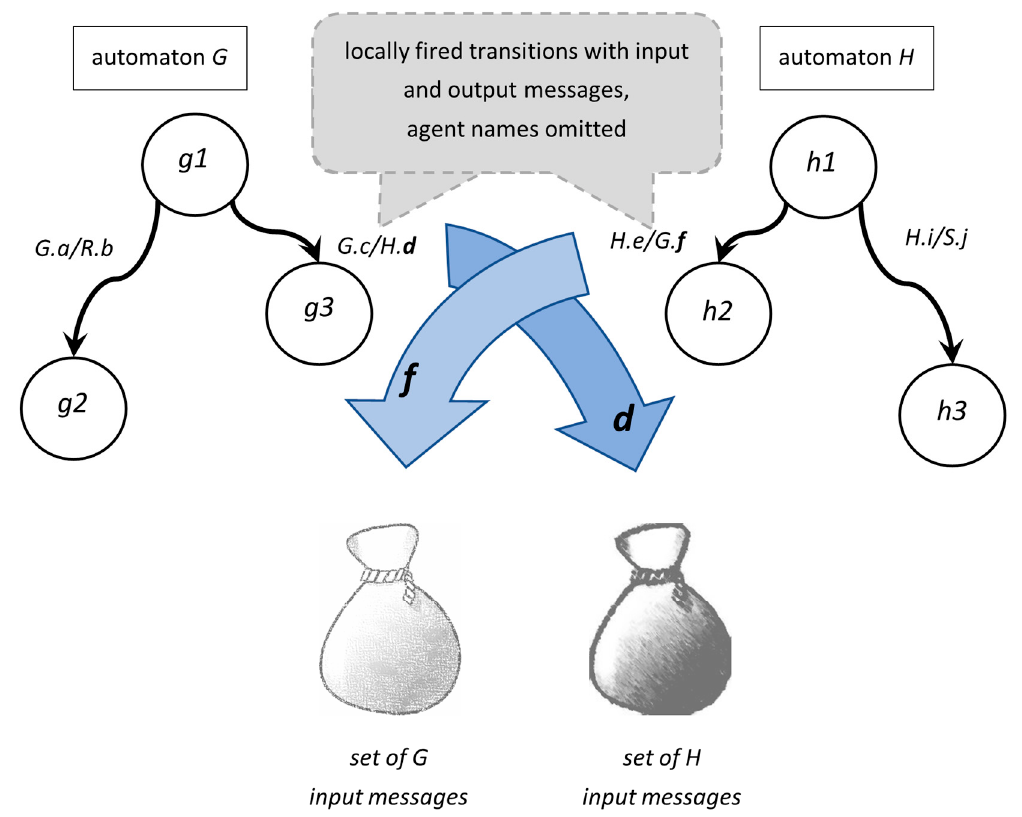
Figure 4. Asynchronous automata model.